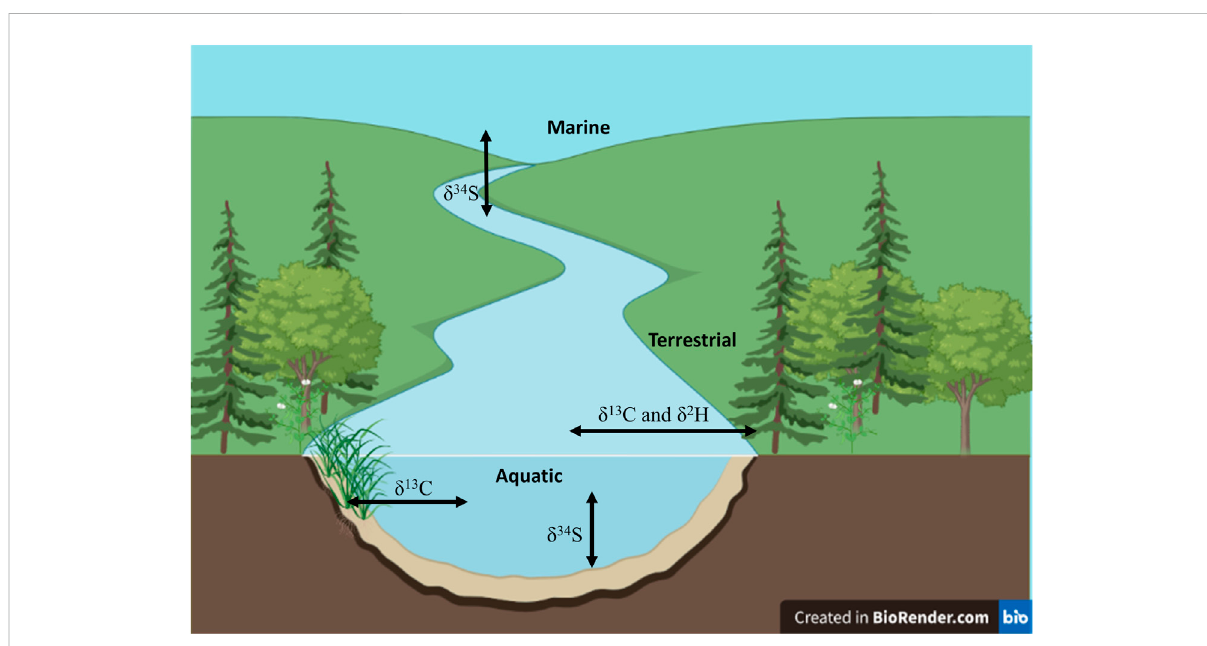
FIGURE 2 Schematic drawing illustrating the various stable isotopes that can be used to differentiate between use of different coupled environments (i.e. benthic-pelagic, littoral-pelagic, aquatic-terrestrial and freshwater-marine). The fi gure was created with